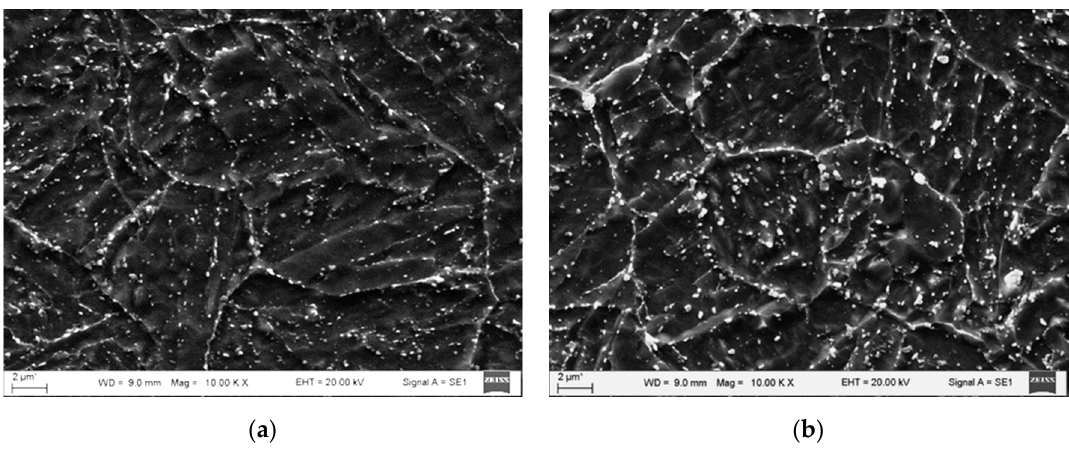
Figure 1. SEM (CARL ZEISS MICROSCOPY LIMITED, Cambridge, UK) microstructure of the P91 steel in the as-received condition ( a ) and after 11,000 h of ageing at 650 °C ( b ). in the as-received condition ( a ) and after 11,000 h of ageing at 650 ◦ C ( b